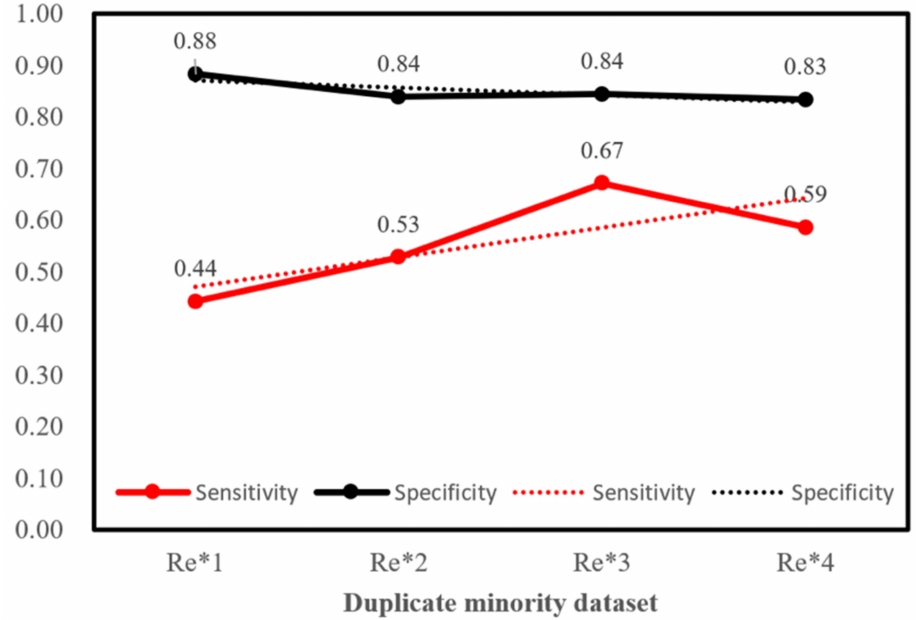
Figure 5. The minority dataset was replicated several times in order to reduce data imbalance, and